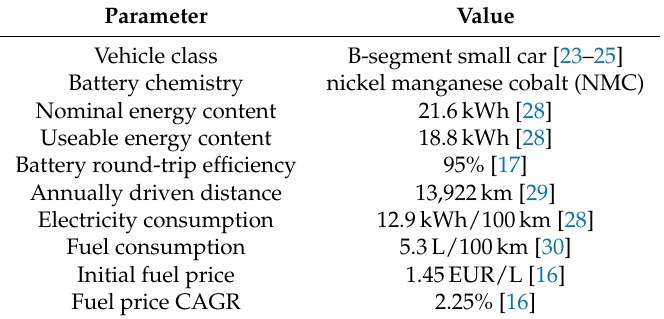
Table 2. Parameters for the electric vehicle (EV) and the internal combustion engine (ICE)